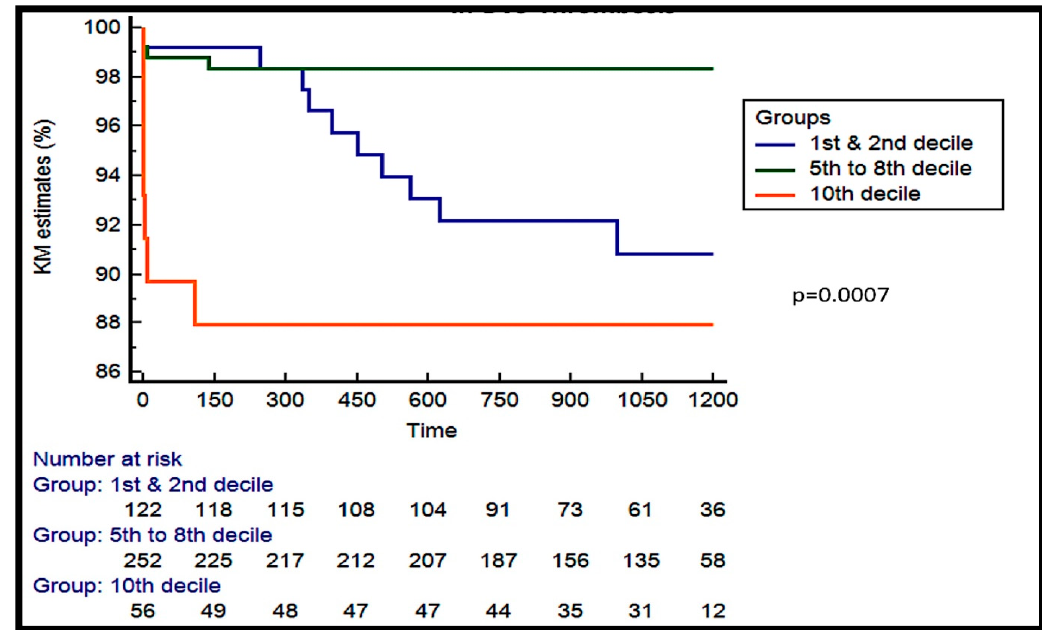
Figure 1. Kaplan-Meier analysis of the true final BRS diameter to RVD divided in 0.1 percentile interval with respect to scaffold thrombosis.